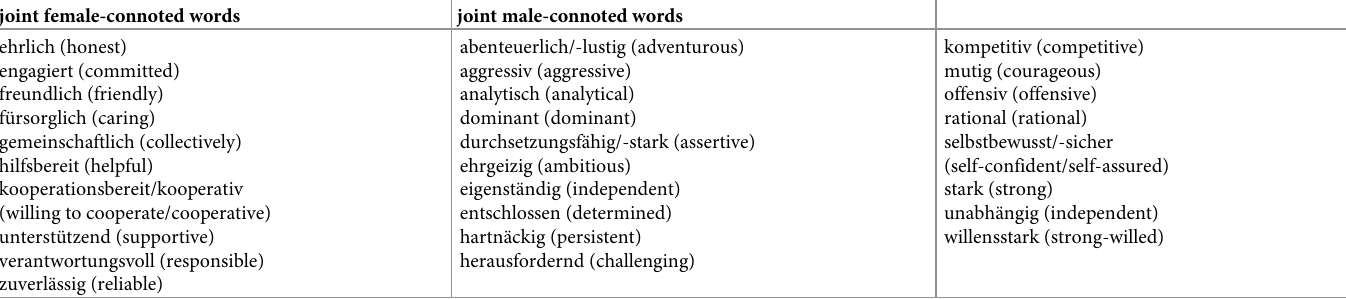
Table 7. Adjectives that have been assigned to the same gender category by all four technologies. Word lists for Stafff were created using data collected from German FEA and Ausbildung.de ( n = 86,